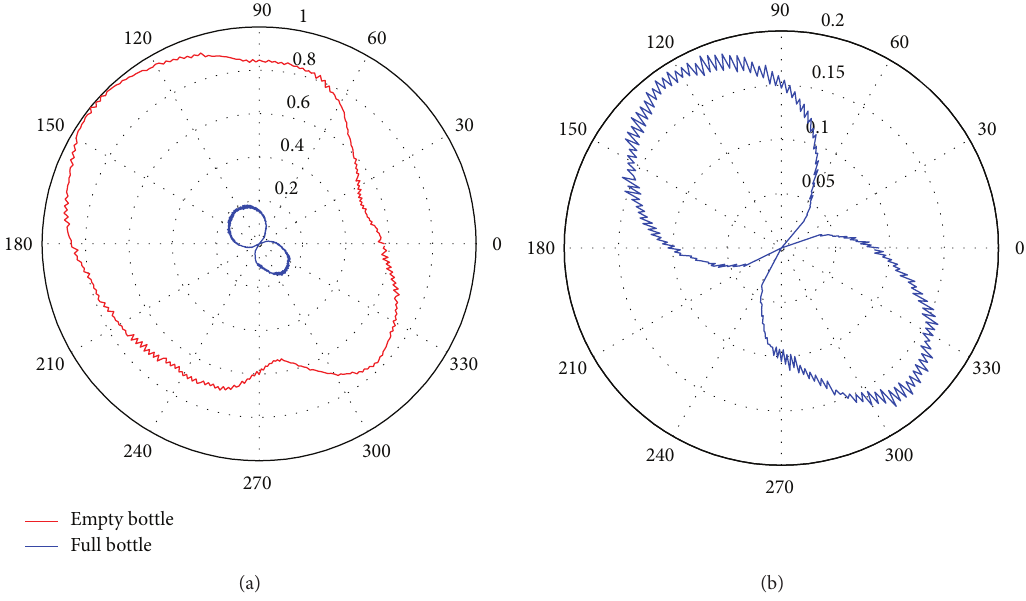
Figure 4: Percentage of received power, using tag 1, around bottle 2.